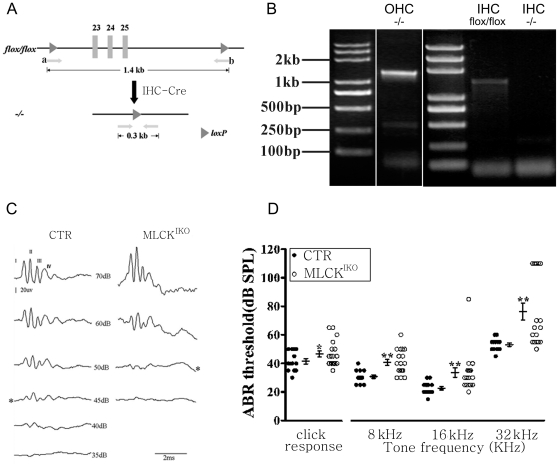
Disruption of the Mylk gene in IHCs and ABR threshold analyses.(A) Generation of knockout mice with deletion of Mylk in the IHCs (schematic). The 1.4-kb genomic DNA fragment contains Mylk exons 23–25 (Mylk accession number: NC_000082), which encode the adenosine triphosphate-binding site of the kinase. Mice containing the floxed allele were crossed with IHC-Cre mice to generate Mylkflox/+ (CTR) and Mylkflox/flox;IHC-Cre (MLCKIKO) mice. The locations of PCR primers a and b are indicated by arrows. (B) DNA isolated from CTR and MLCKIKO mice IHCs and OHCs was analyzed by PCR; the 1.4-kb and 308-bp products represent CTR and mutated MLCK, respectively. (C) Representative ABR waveforms measured in CTR and MLCKIKO knockout mice at 4–6 months in age measured in response to click stimuli of the indicated intensities. *ABR threshold. (D) Summary of the ABR thresholds for click and tone stimuli in 4- to 6-month-old control (filled circles) (n = 13) and MLCK-null mice (open circles) (n = 18). Averaged data (means ± S.E.) are shown for the click and tone stimuli. *Significant difference compared with control mice are shown. *, P<0.05; **, P<0.01.